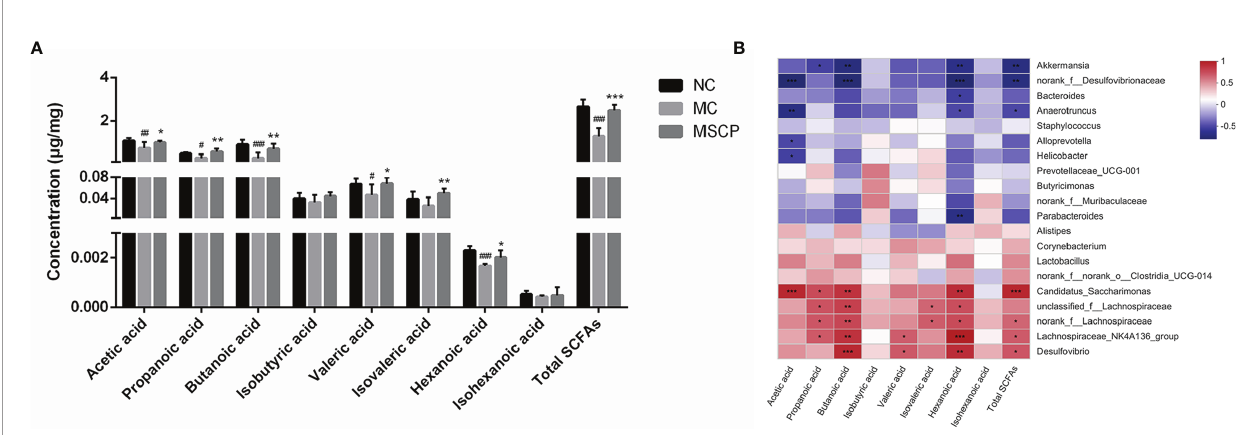
FIGURE 11 | Determination of short-chain fatty acids (SCFAs) in cecal contents. (A) The exact amount of SCFAs in cecal contents, including acetic, propanoic, butanoic, isobutyric, valeric, isovaleric, hexanoic and isohexanoic acids, as detected by GC – MS method. (B) Heatmap showing Spearman ’ correlation coef fi cient with p < 0.05 between several signi fi cant changed fecal SCFA and genera bacteria. Red cells represent positive correlation and blue cells represent negative correlation. Data are expressed as mean ± SD. # p < 0.05, ## p < 0.01, ### p < 0.001 compared with NC group; * p < 0.05, ** p < 0.01, *** p < 0.001 compared with MC